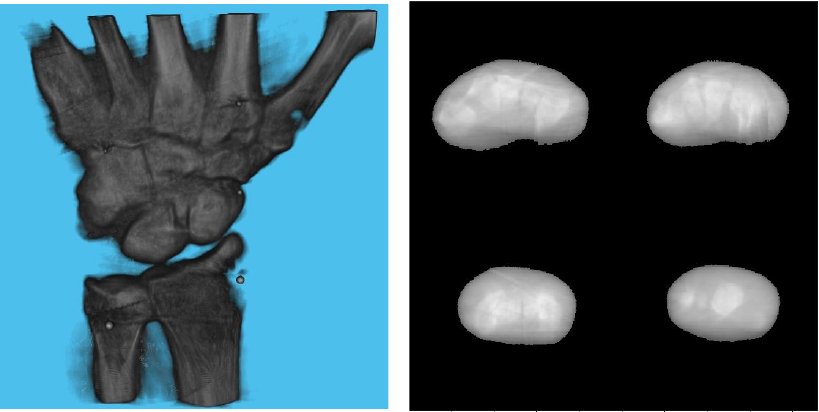
Figure 11. Volume rendering of the reconstructed volume using a 3 mm calibration board and 2 mm marker ( left ). Four fixed slices (top left: metacarpals, top right: carpals, bottom right: carpals, bottom left: radius and ulna) of the volume ( right ).